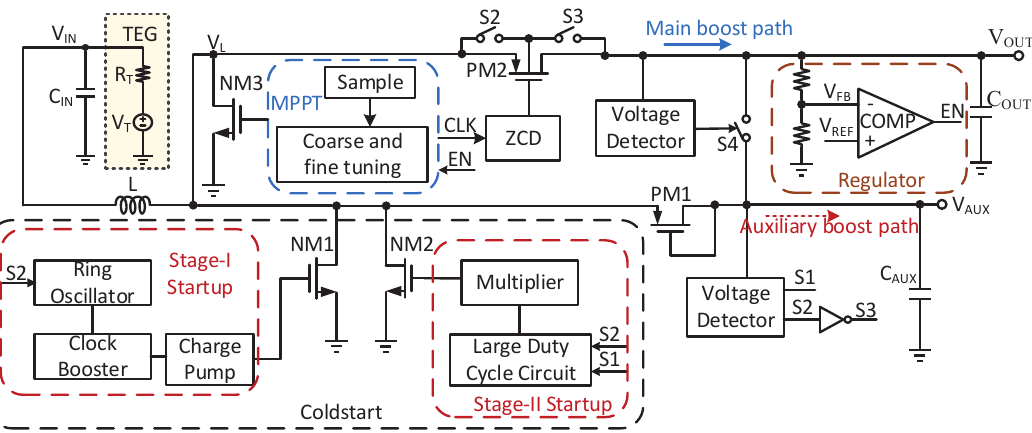
Figure 1. Architecture of the proposed